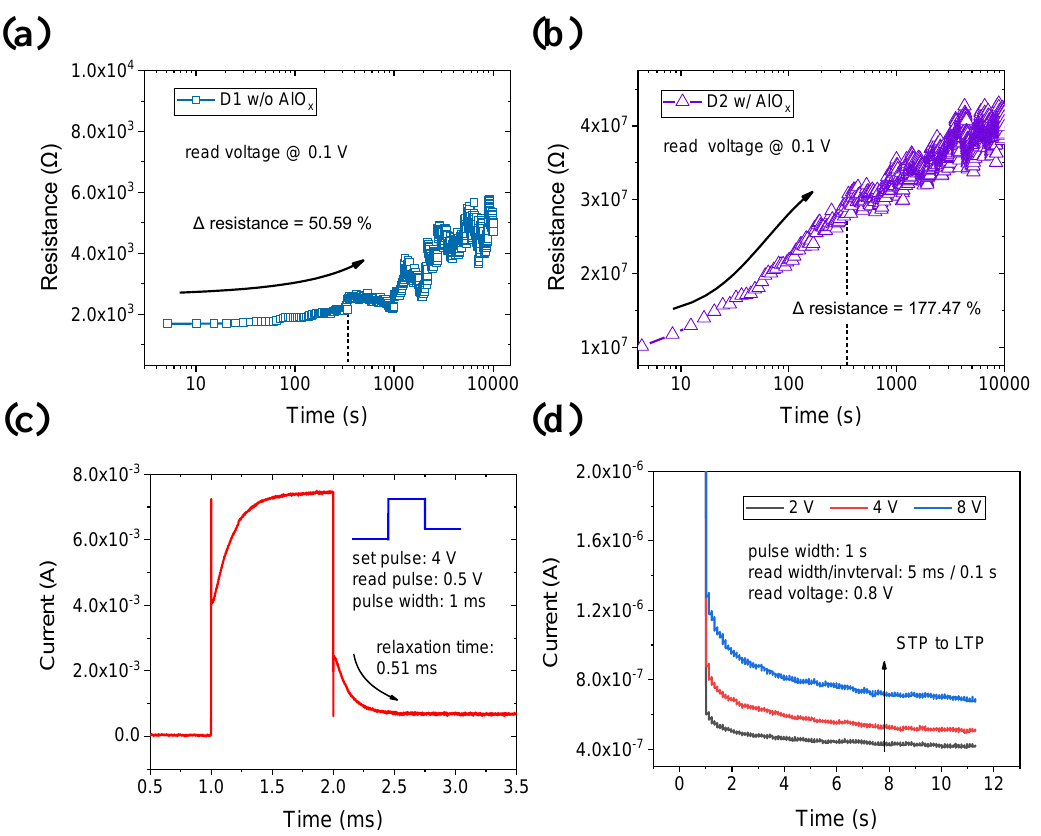
Figure 4. The retention of ( a ) device 1 after forming/reset/set switching and ( b ) device 2 after only set switching. Device 1 tries to maintain LTS, while device 2 has a short-term characteristic. In pulse mode, ( c ) the relaxation time and ( d ) STP to LTP control by pulse amplitude of device 2. The relaxation time is longer as the amplitude increases.